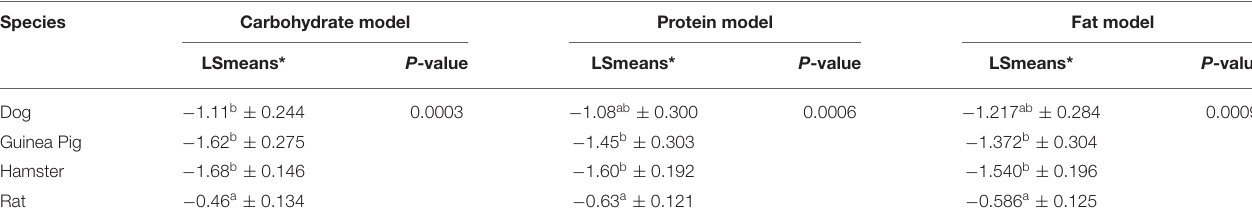
TABLE 5 | Fecal bile acid (BA) concentrations (lognormal data scale) in dogs, guinea pigs, hamster and rats for the model equations developed.